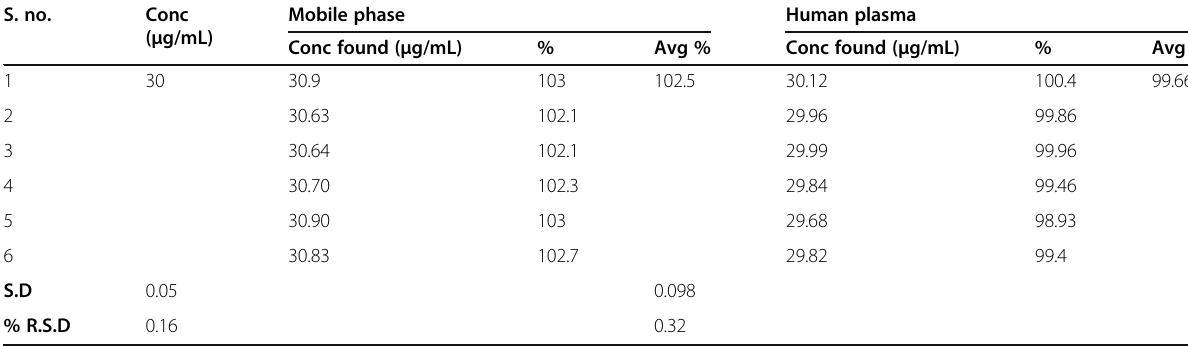
Table 2 Precision table of Tezacaftor in Mobile phase and Human plasma S. no.